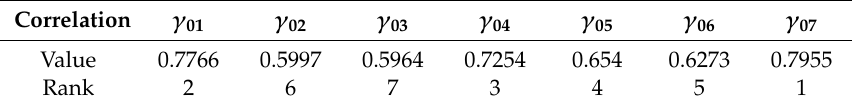
Table 8. Grey correlations and ranks between intra-regional di ff erence of provincial e ffi ciency di ff erence of Chinese township hospitals and the